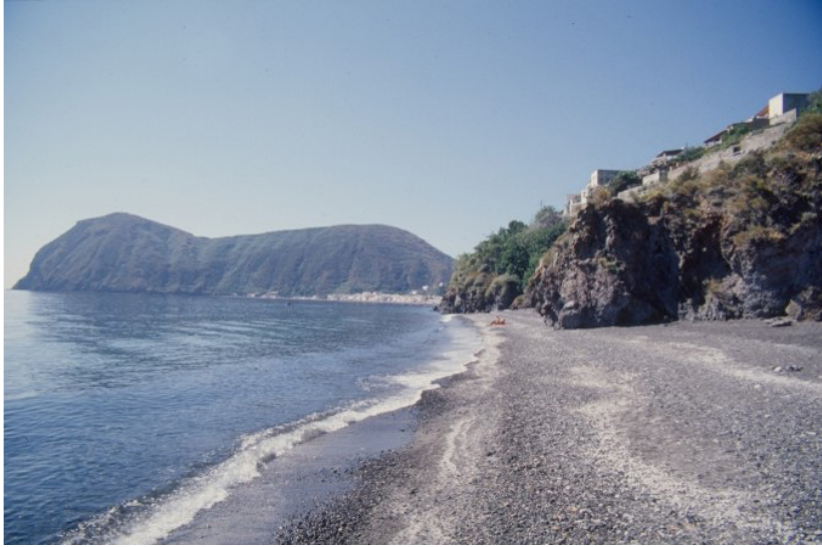
Figure 5. Lipari coast with obsidian. Picture from north with Monte Rosa in the